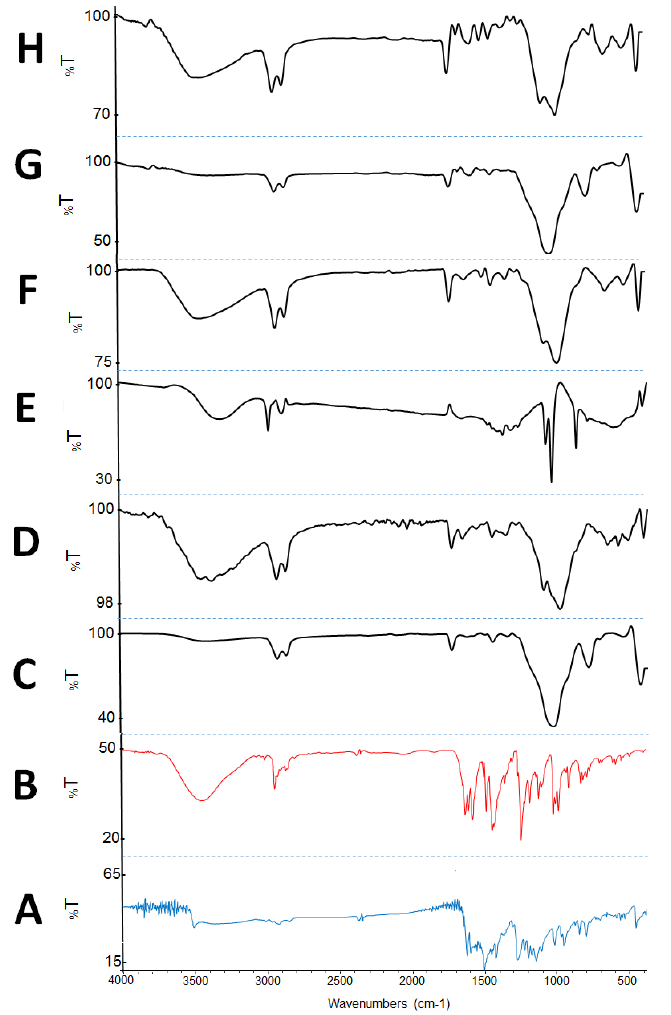
Figure 9. FTIR results of ( A ) pure CUR, ( B ) pure PP, ( C ) F1A, ( D ) F1N, ( E ) F2A, ( F ) F2N, ( G ) F6A and ( H ) F6N.